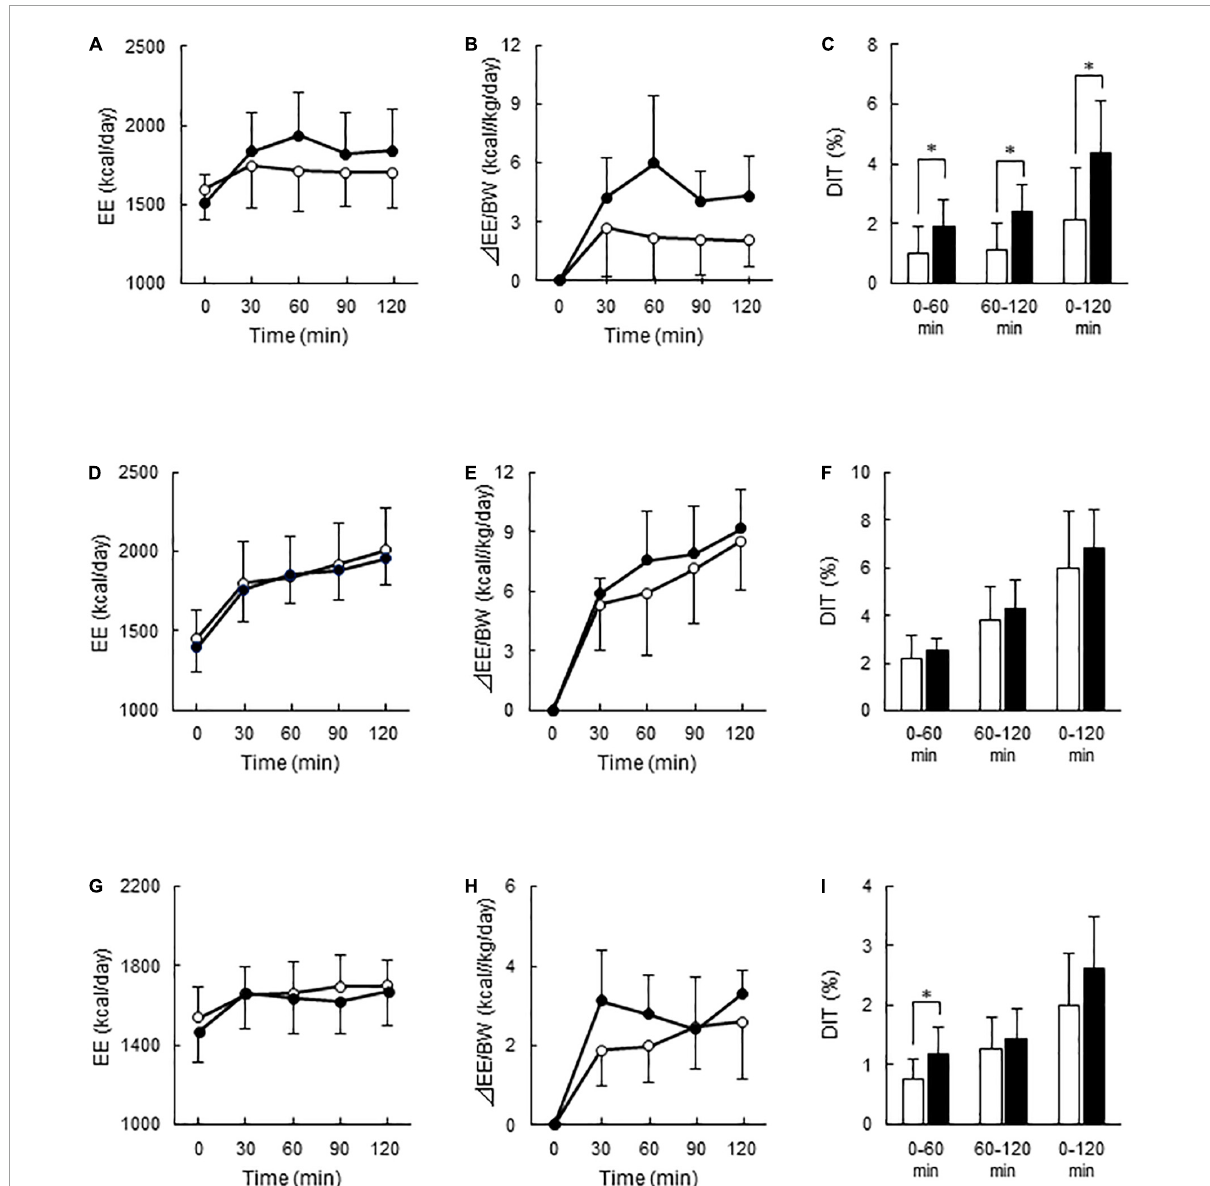
FIGURE3 Energy expenditure and diet-induced thermogenesis after meal ingestion in the Low- and High-BAT groups. Whole-body energy expenditure (EE) was measured after ingestion of a carbohydrate-rich C-meal (A–C) , a protein-rich P-meal (D–F) , and a fat-rich F-meal (G–I) at 7.9 kcal/kg body weight (BW). Open circles and columns: Low-BAT group. Filled circles and columns: High-BAT group. (A,D,G) Whole-body EE. (B,E,H) Postprandial change in EE calculated as relative to BW. (C,F,I) Diet-induced thermogenesis (DIT) calculated as the area under the curve in (B,E,H) and expressed as % of ingested energy. Values are expressed as mean ± SD . ∗ P <